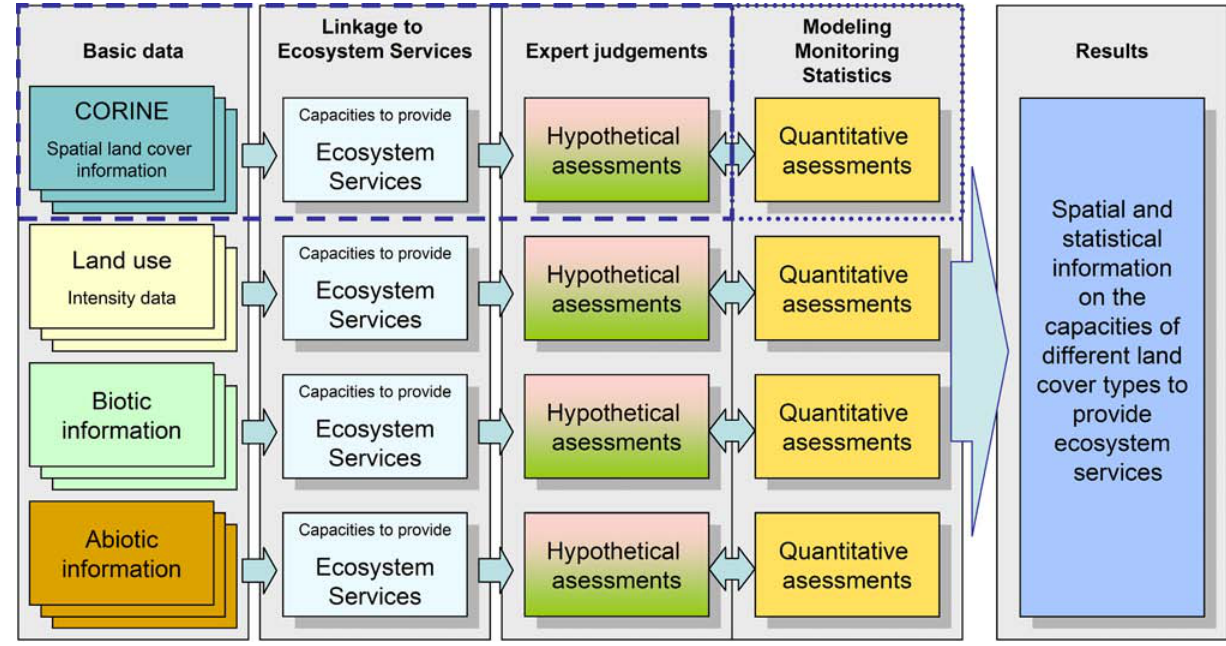
Figure 5: Conceptual framework to assess and quantify landscapes’ capacities to provide ecosystem services. The dashed and dotted lines indicate the components presented with examples in this